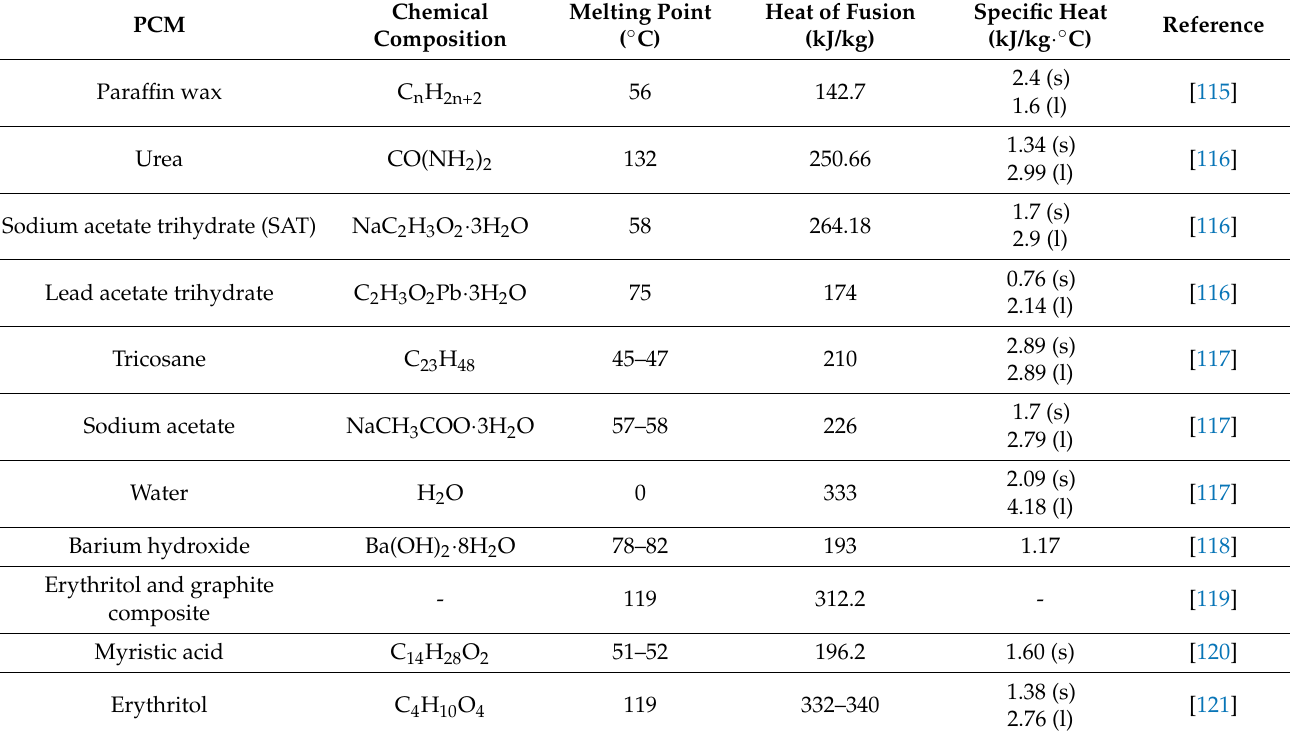
Table 5. A few potential PCMs for energy storage in SWH